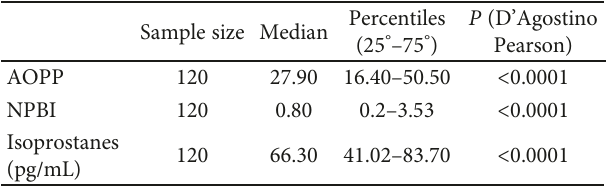
Table 2: Summary statistic for oxidative stress markers in cord blood.